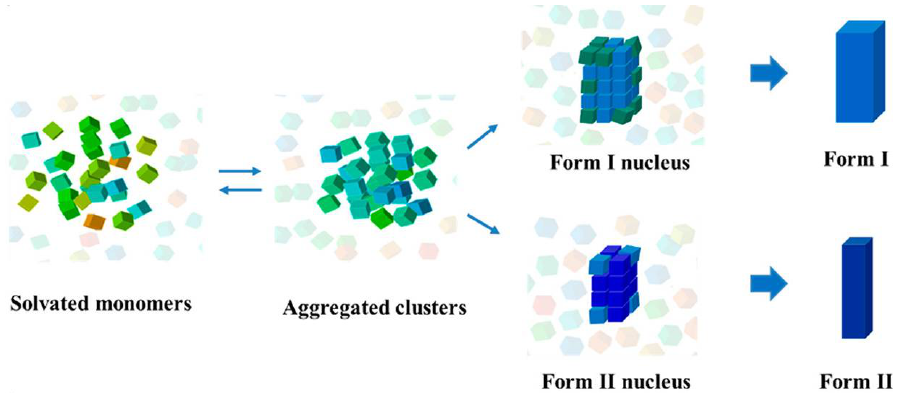
Figure 8. Proposed nucleation pathway of concomitant nucleation of a dipolymorphic system. The colors of solvated monomers indicate different solvation states [136]. Reprinted/adapted with permission from [136]. Copyright 2020, copyright Tang, W.; Sima, A.D.; Gong, J. et al.